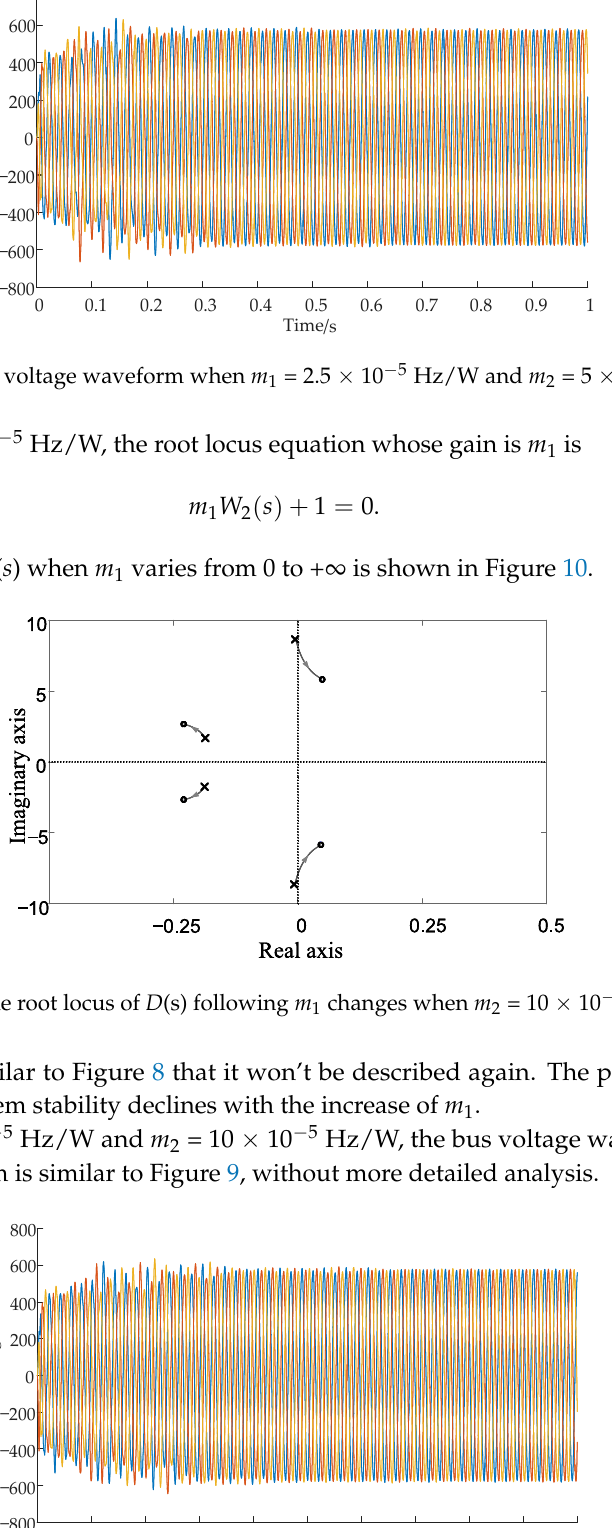
Figure 11. The bus voltage waveform when m 1 = 2 × 10 − 5 Hz/W and m 2 = 10 × 10 − 5 Hz/W. (3) When m 2 = 2.5 × 10 − 5 Hz/W, the root locus equation whose gain is m 1 is